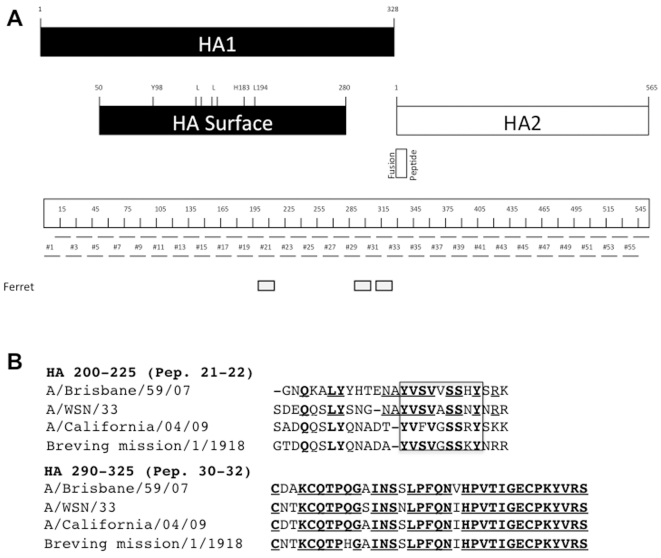
Summary of the immunoblot analysis using serum of ferrets immunized with TIV alone or with PapMV nanoparticles.
A, Schematic representation of HA protein sequence and position of the different 15-aa peptides on the HA sequence. Small gray rectangles represent peptides that reacted exclusively with serum of ferrets immunized with TIV (2009–2010) + 150 µg PapMV nanoparticles, or peptides that reacted only with serum of mice immunized with TIV (2008–2009) + 30 µg PapMV nanoparticles. Black rectangles represent the extent of peptides that reacted in both species. B, Amino acid sequence alignment of peptidic regions that reacted with serum of both species. A/Brisbane/59/07 is the H1N1 vaccine strain, A/WSN/33 is the mouse-adapted strain, A/California/04/09 is the 2009 pandemic strain, and A/Brevig Mission/1/1918 is the Spanish flu strain. Identical amino acids are in bold and underlined. A conserved region of HA is boxed.